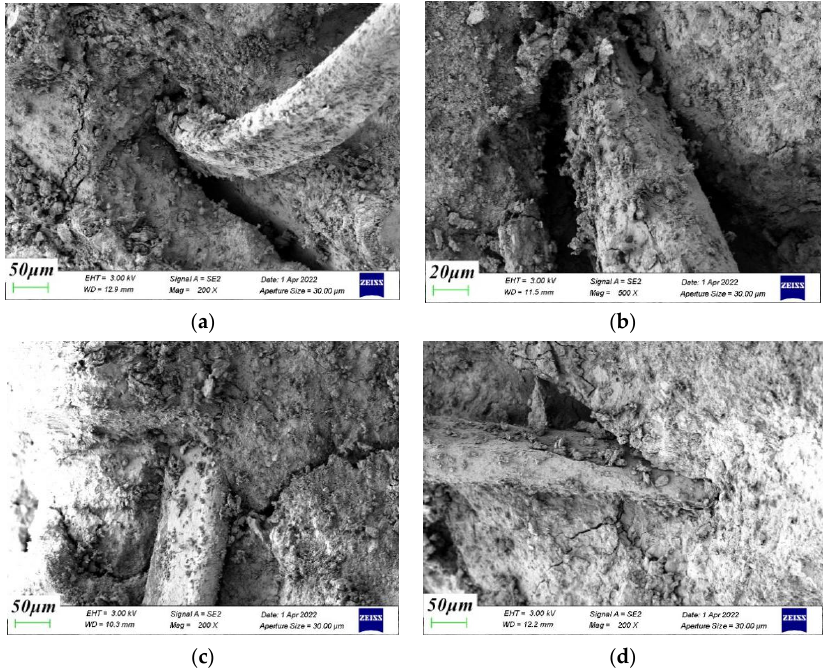
Figure 16. Transition zone of fiber–aggregate interface. ( a ) 0 MPa, ( b ) 6 MPa, ( c ) 12 MPa, ( d ) 18 MPa.